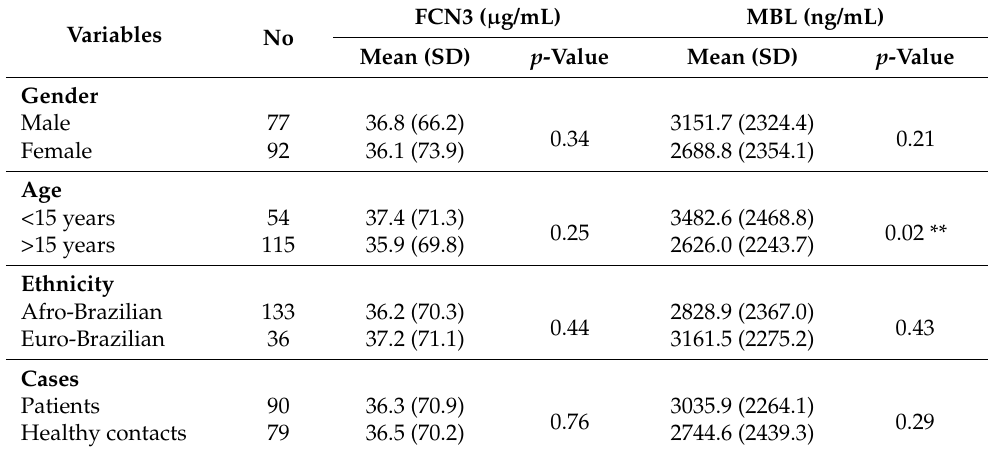
Table 2. Associations between FCN3 and MBL concentrations and sociodemographic characteristics in leprosy patients and healthy contacts ( n = 169).